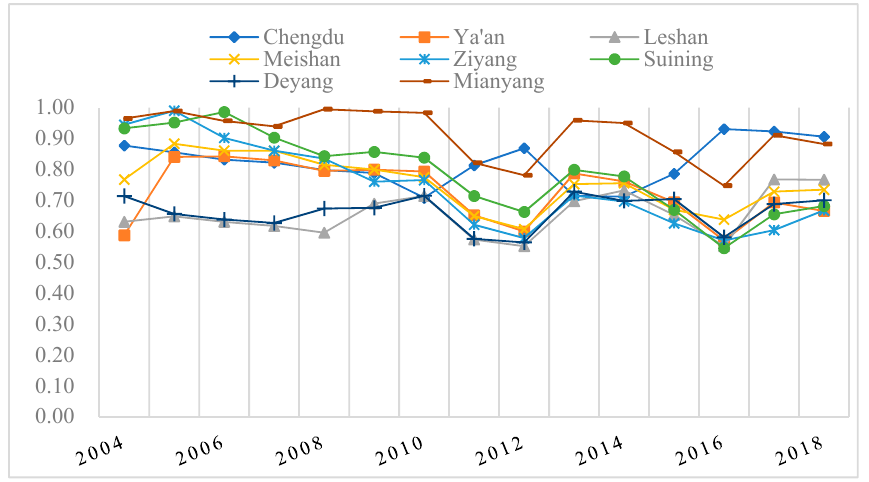
Figure 3. The industrial urban co-agglomeration levels from 2004 to 2018.